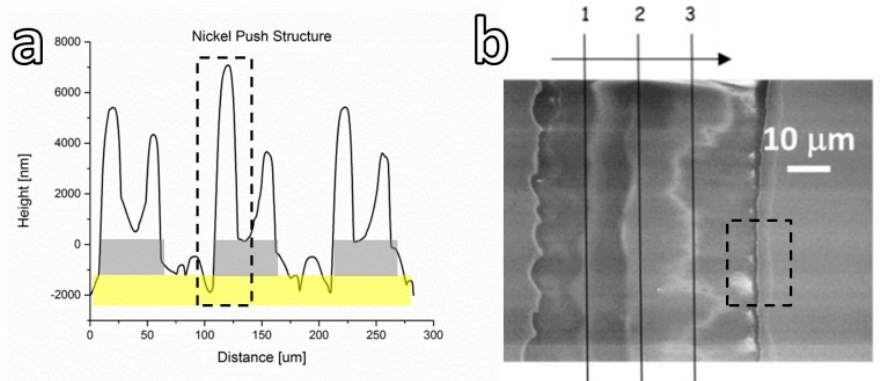
Figure 12. A color-enhanced example of a push structure using 640 nm nickel films on Par-C substrates, as characterized by ( a ) profilometry and ( b ) FESEM. Successive, overlapping laser scans induce a progressive and directional dewetting front in the nickel film that produces thicker, smoother ridges without the need for additional depositions. Yellow demarks the Par-C, while grey demarks the original surface of the nickel. The dotted square highlights the pushed ridge.